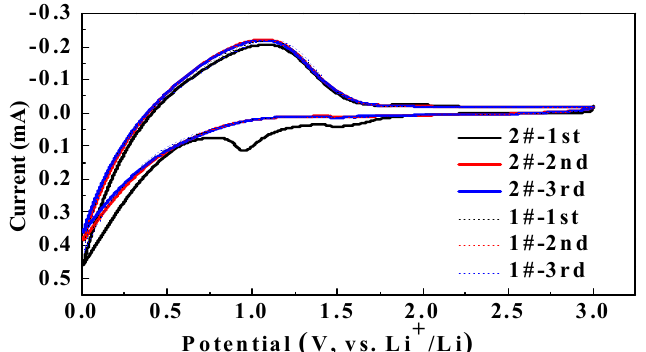
Figure 2. The CV plots for the first three cycles of the Li/graphite half cells without additive and with 0.5% DDDT. with 0.5%